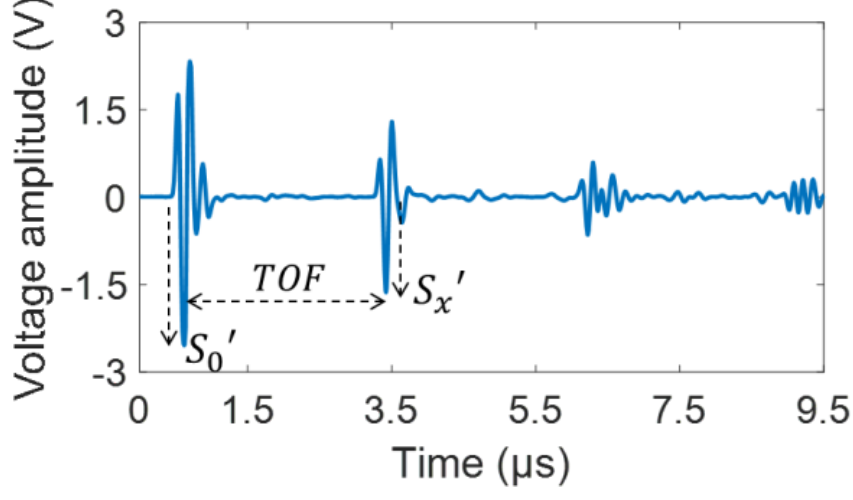
Figure 6. Typical time-domain ultrasonic signal measured from the PE mode.